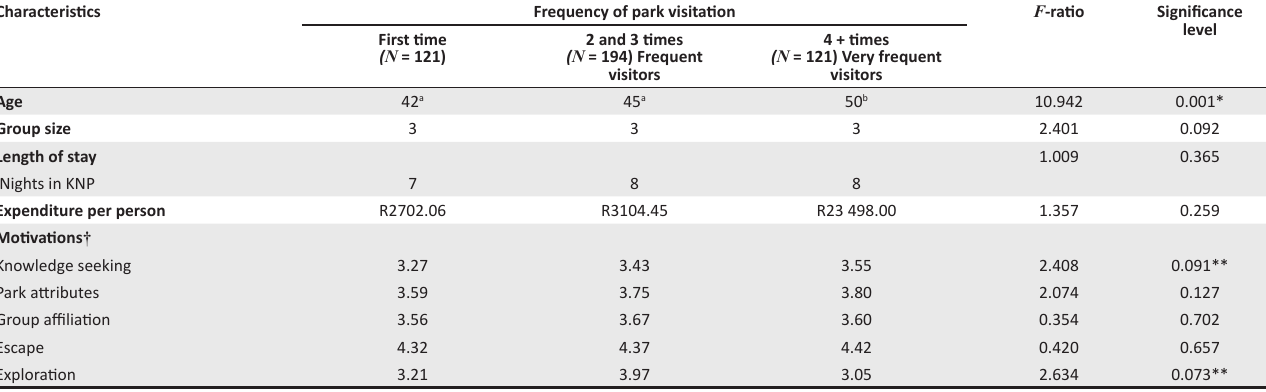
TABLE 4: Results of analysis of variance and Tukey’s post hoc multiple comparisons for Kruger National Park visitor characteristics of first-timers and repeaters.